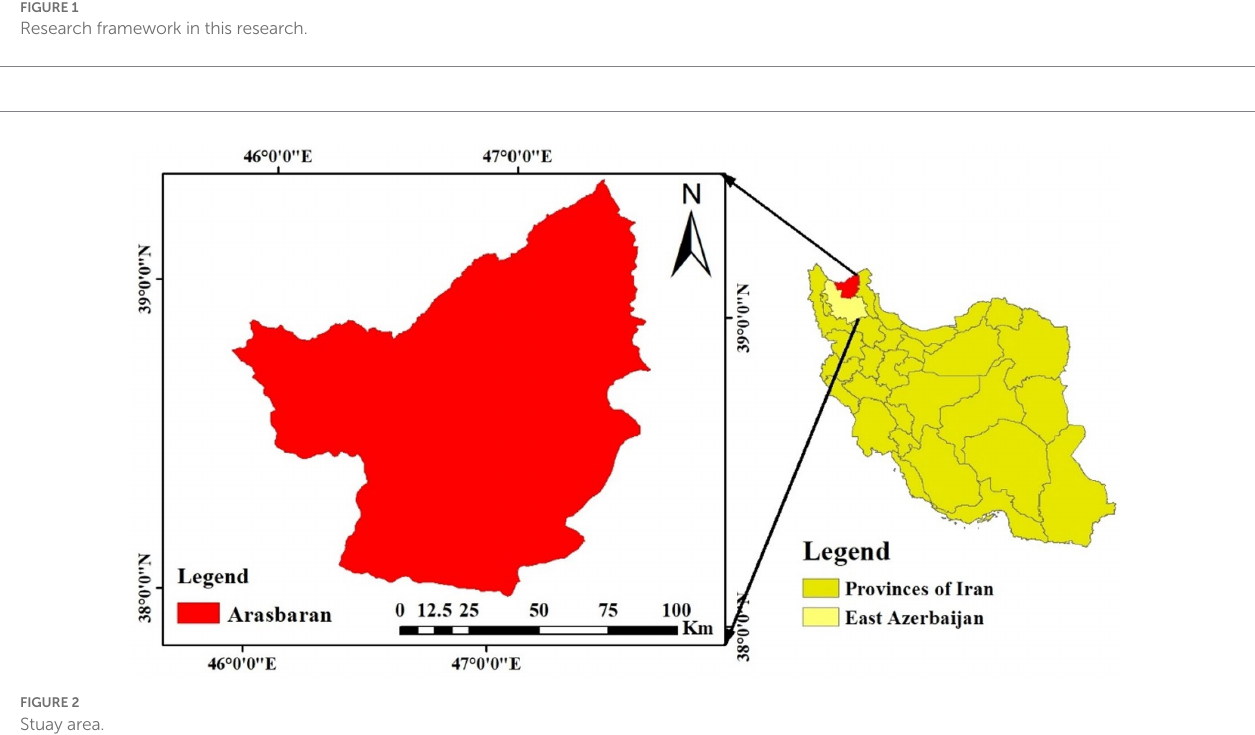
FIGURE 1 Research framework in this research.